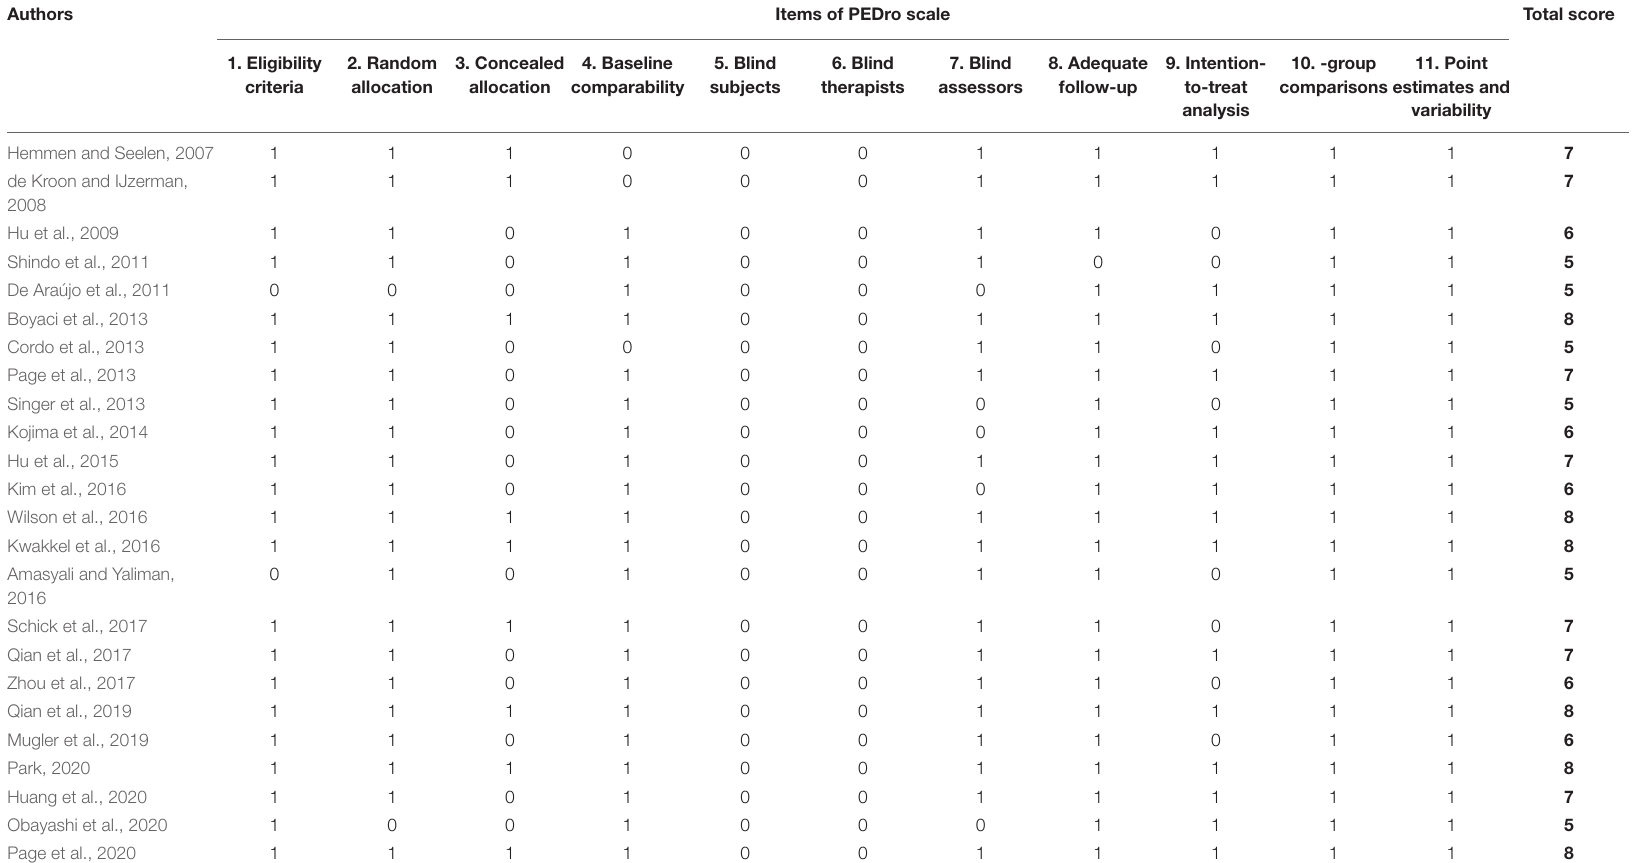
TABLE 2 | Methodological quality assessment of included studies utilizing PEDro